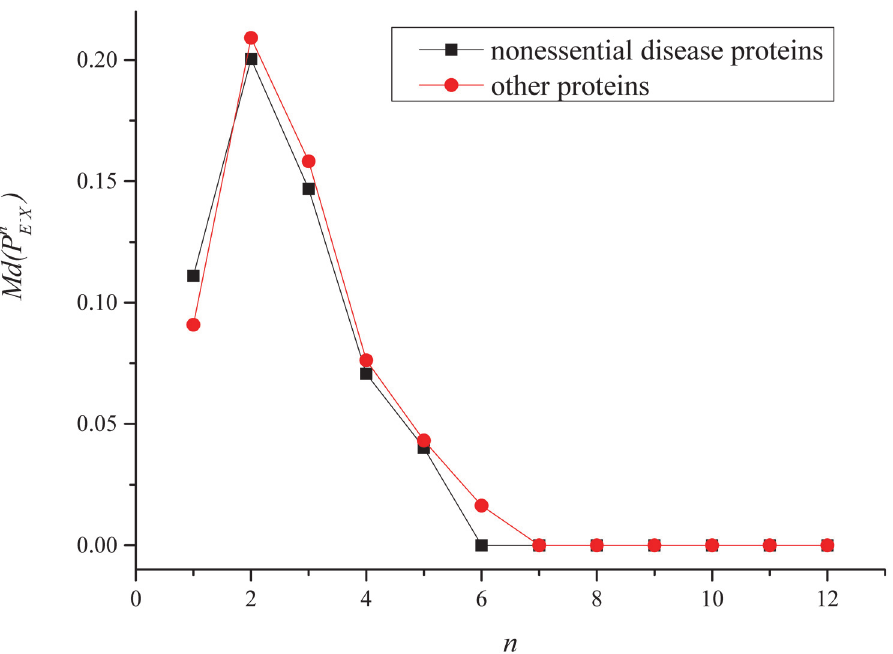
Fig 1. Median values of the proportions of non-disease essential proteins among n ( n 2 {1, 2, ... , 12}) neighbors in the protein interaction network constructed based on the i2d database.